Question: Summarize what this figure shows in one sentence.
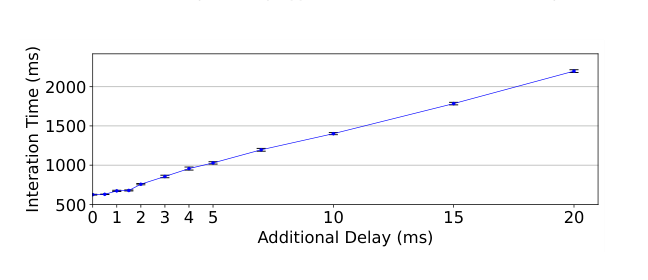
Answer: The end-to-end training time per iteration in BERT model (ms) vs the additional delay injected in every all reduce call (ms). Error bar is plotted in black.